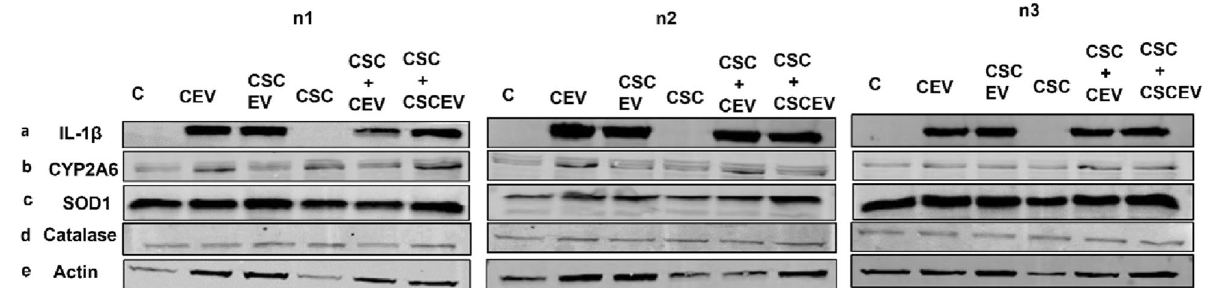
Figure 6. Effect of EVs derived from uninfected macrophages on the levels of IL-1β, CYP2A6, and AOEs in SHSY-Y5 neuronal cells. The neuronal cells (0.1 million cells/well/12well plate) were treated with EVs-derived from control (DMSO) and CSC-exposed (10 µg/ml/day for 7 days) U937 macrophages once daily for 2 days in the presence and absence of CSC (10 µg/ml/day). We observed more than 50% cell death after 2 days of treatment. Therefore, we harvested the cells after 2 days of treatment. We performed a Western blot with an equal amount of protein loaded (5 µg of protein) to measure the protein expression of IL-1β ( a ), CYP2A6 ( b ), and antioxidant enzymes ( c & d ). ‘ n ’ represents number of replicates. CEV represents EVs isolated from the control group; CSCEV represents EVs isolated from the CSC-treatment group.